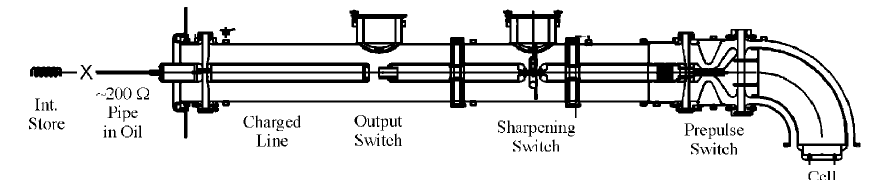
FIG. 31. The 7 : 8 (cid:31) RITS pulse forming